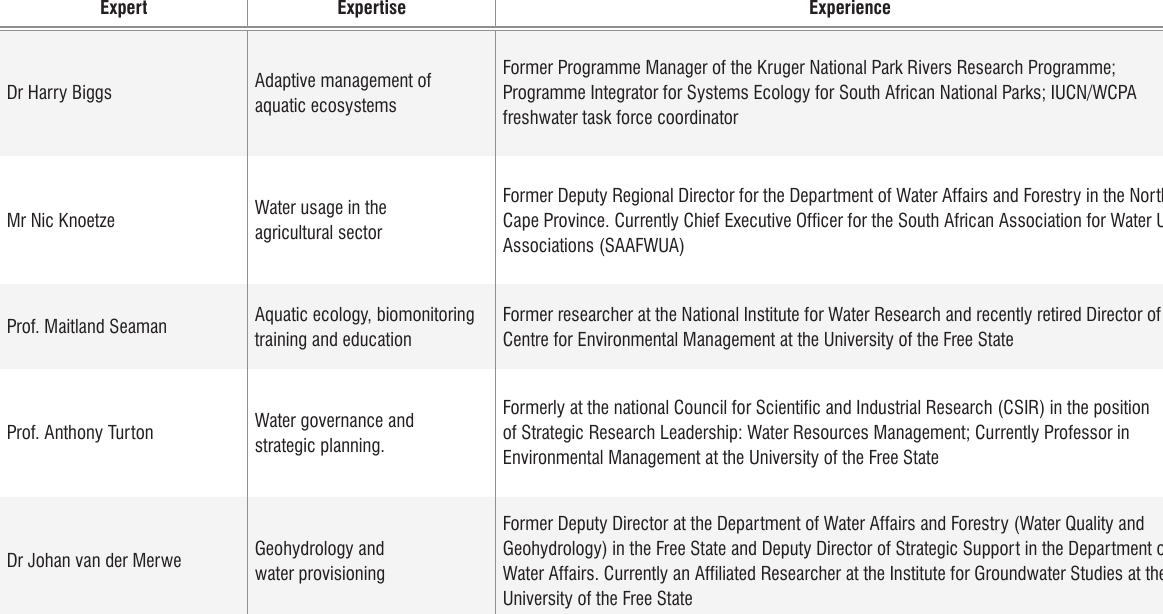
The panel of scientists and practitioners specifically selected for their experience in different parts of the water sector. Expert Expertise Experience